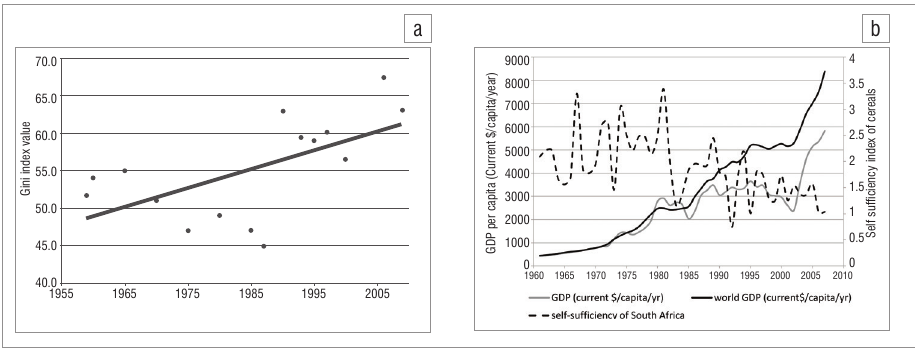
Figure 1: Corresponding information about South Africa: (a) trend of the Gini index of South Africa and (b) trends of GDP and self-sufficiency in South Africa compared with the GDP world